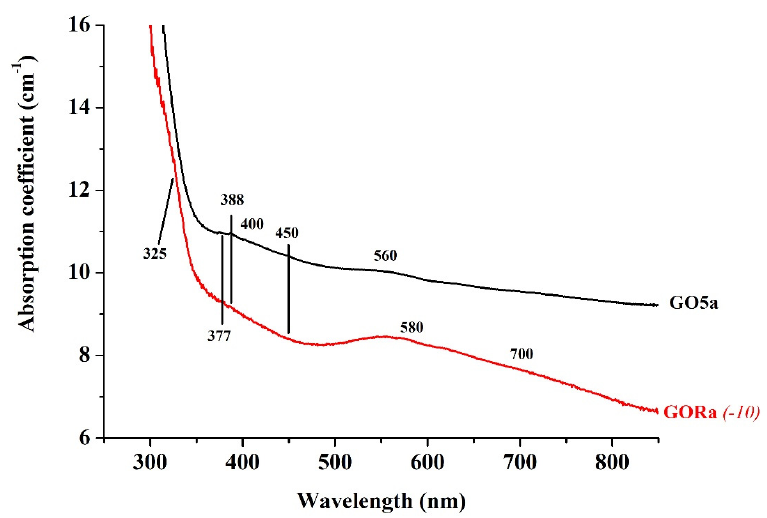
Figure 8. UV-Vis spectra of the pink (slightly purple) sample GO5a (black trace) and the blue sample GORa (red trace) from Gorgona (Xanthi). Red spectrum is shifted vertically (value in parenthesis) for clarity.